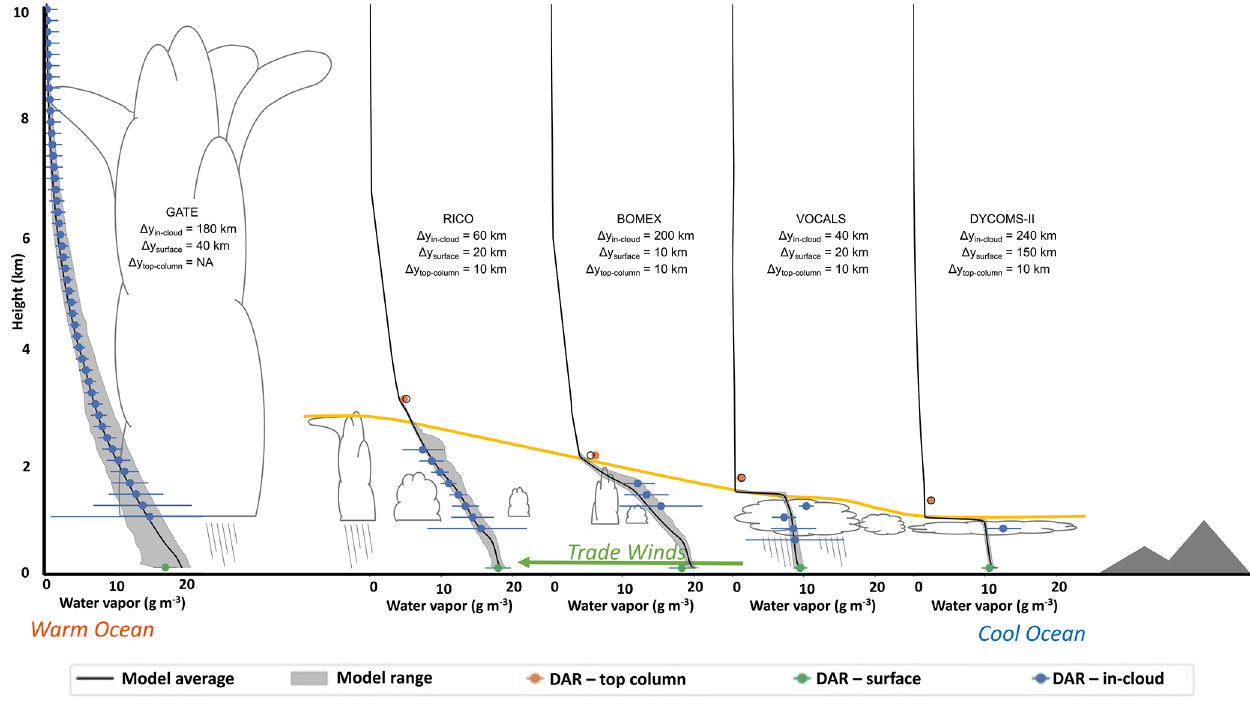
Figure 12. Summary of humidity retrieval capabilities for an intelligently scanned DAR system displayed within the context of the subtropical-to-tropical cloud transition regimes. For each LES case, we present the in-cloud profiles and surface humidity estimates cal- culated using the cloud-to-surface partial column with error bars representing 1 σ random error. In-cloud estimates in the lower troposphere with relative uncertainty greater than 100% are excluded. The along-track averaging distances for the different retrieval quantity estimates are listed above. The top-column representative water vapor density value (orange circles) is compared to the model truth value (open black circles). While the retrieval biases are nearly identical for the fixed-nadir case with large along-track averaging, the precision is degraded and can be assessed by examining the precision scaling plots in Figs. 3d, 5d, 7d, 9d, and